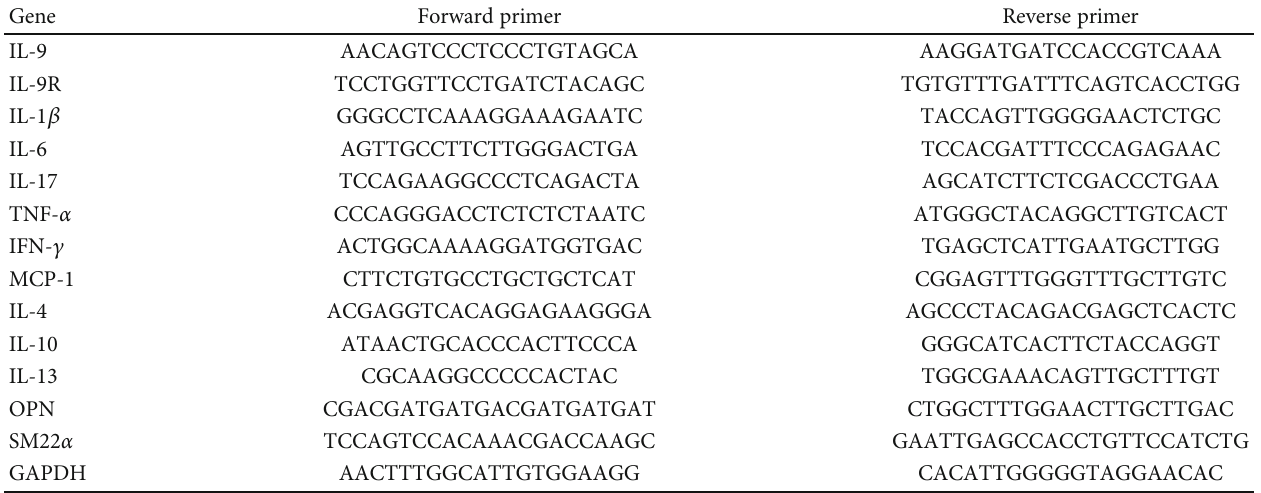
Table 1: RT-PCR primers used.